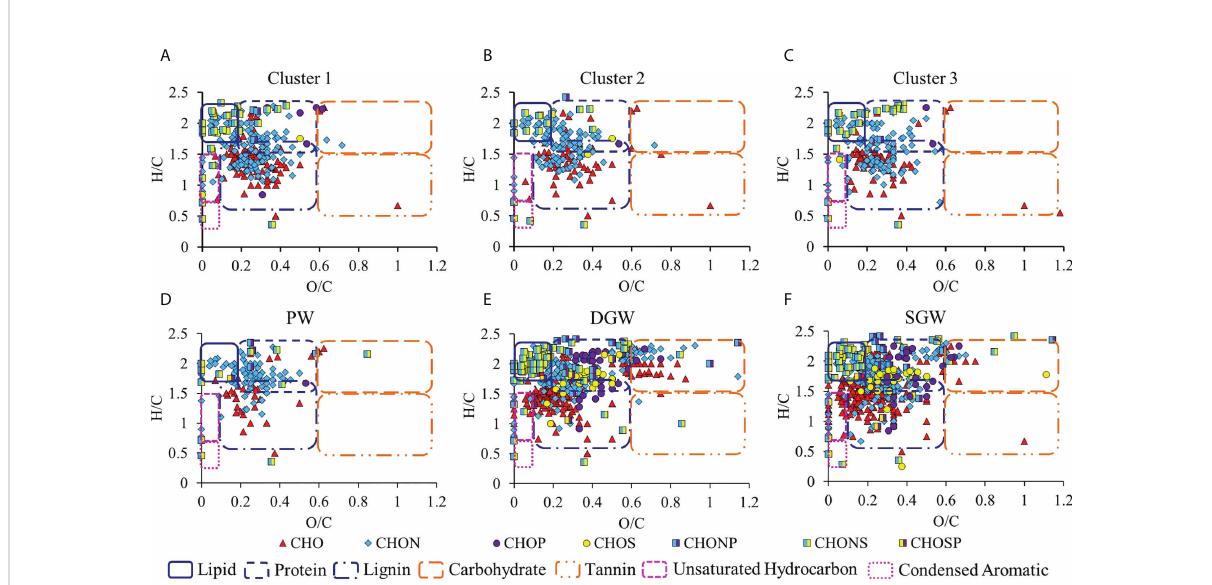
FIGURE 9 DOM compound classi fi cations by van Krevelen diagram (O/C vs. H/C elemental ratios) for PCA clusters (A) 1, (B) 2, and (C) 3, (D) porewater (PW), (E) deeper groundwater (DGW), and (F) shallow groundwater (SGW). DOM, dissolved organic matter; PCA, principal component